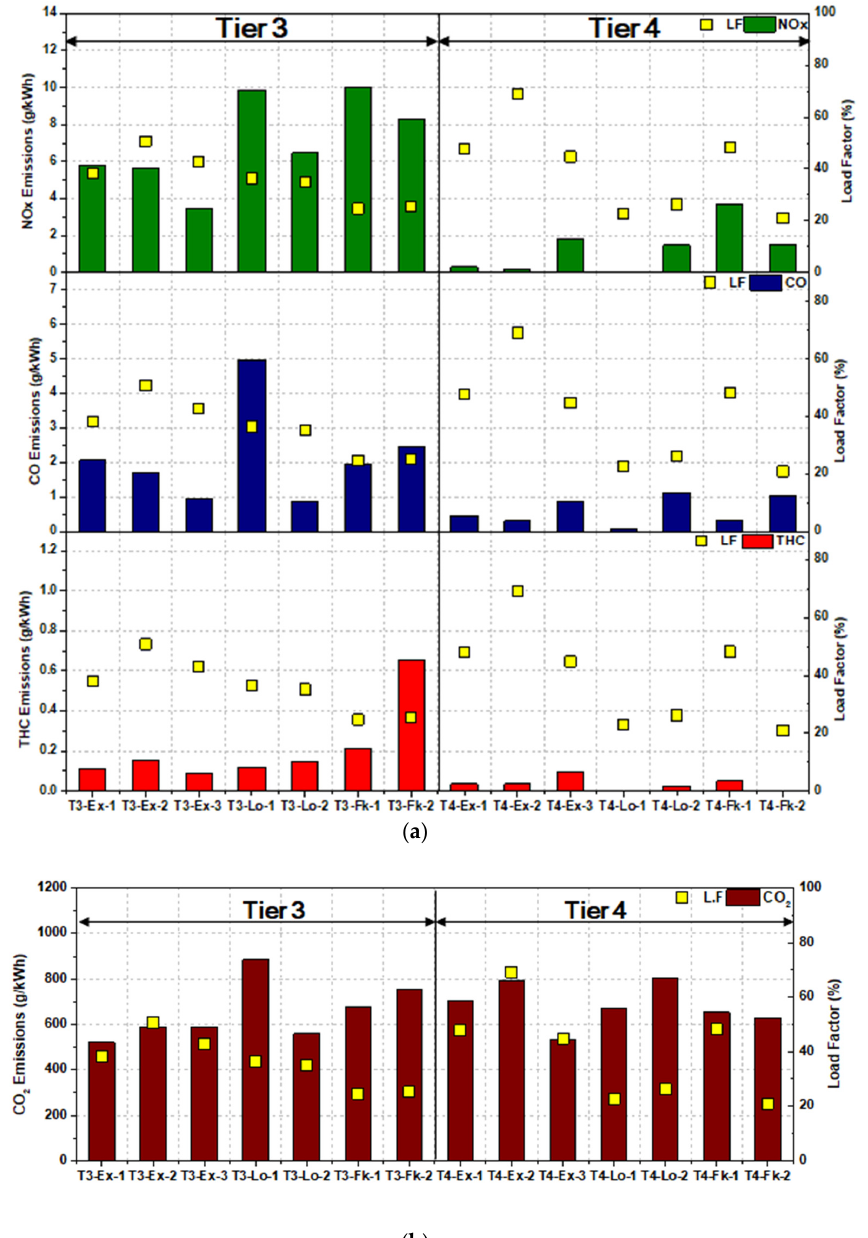
Figure 5. Average brake-specific emissions, engine load factors and power for tested construction machinery. ( a ) Real-world emissions and Load Factor; ( b ) CO 2 emission and Load Factor.